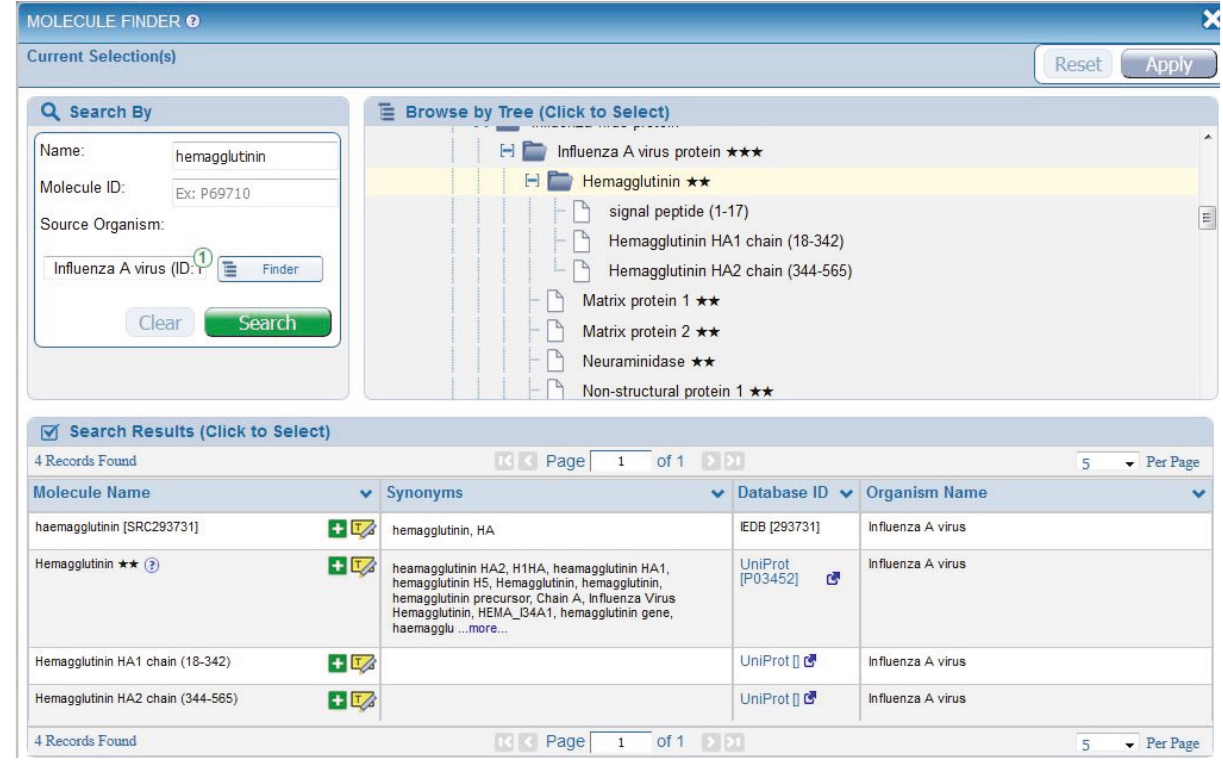
Figure 1: The Molecule Finder can be used to select the source antigen of the epitope. The yellow highlight icon in the bottom table highlights the selection in the tree in the upper right. The green “ + ” icon selects the molecule for the search criteria. The stars next to the molecule name indicate the quality and completeness of the associated reference